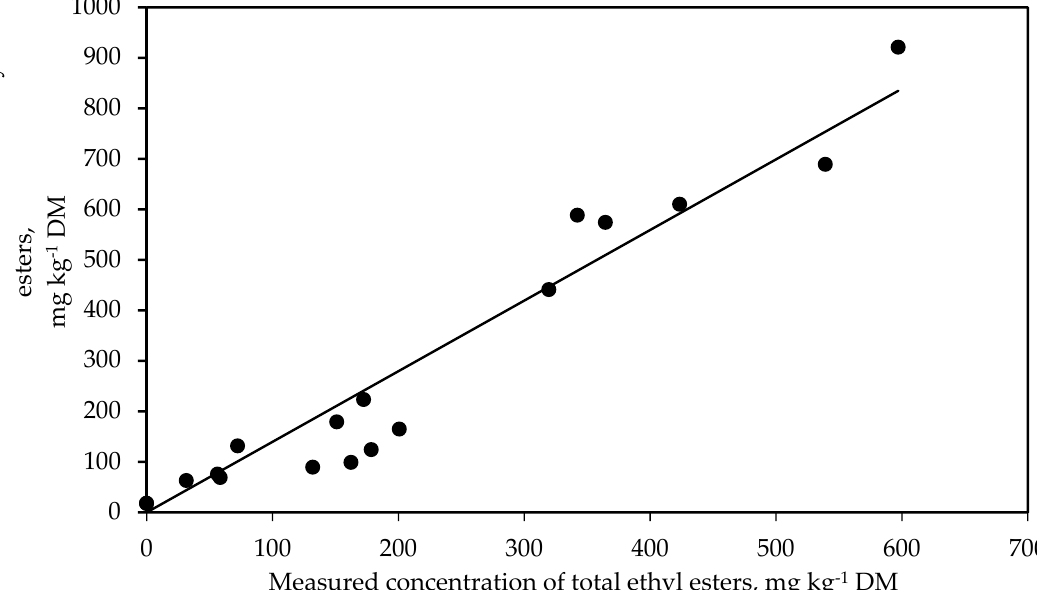
Figure 4. Relationship between the measured concentration of total ethyl esters (sum of ethyl lactate and ethyl acetate) and the predicted concentration of total ethyl esters (sum of ethyl lactate and ethyl acetate) based on Weiss et al. [30] (y = 1.40x, R 2 = 0.93, RMSE = 71.18, p < 0.001, n = 18) in whole-crop rye silage treated with di ff erent additives and stored for 53